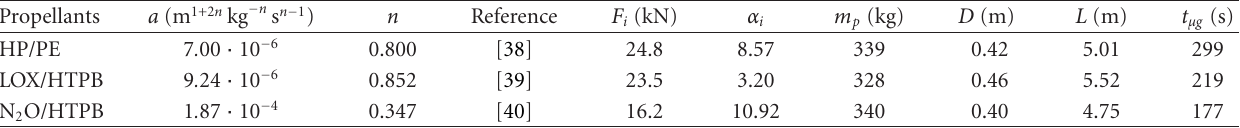
Table 2: Optimal design and performance of sounding rocket for di ff erent propellant combinations.